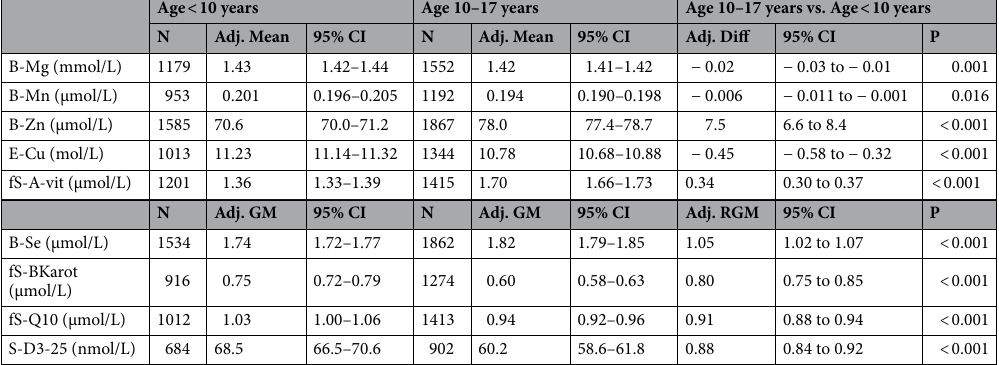
Table 4. Adjusted means (95% CI) for micronutrients in children (age < 10 years vs. age 10–17 years) measured between 1987 and 2020. Adjustment was based on the general linear model, where age group (10–17 years vs. < 10 years) and 5-year time periods were included as categorical covariates. B-Se, fS-BKarot, fS-Q10 and S-D3-25 were logarithmically transformed before analysis. GM geometric mean, RGM ratio of geometric means.